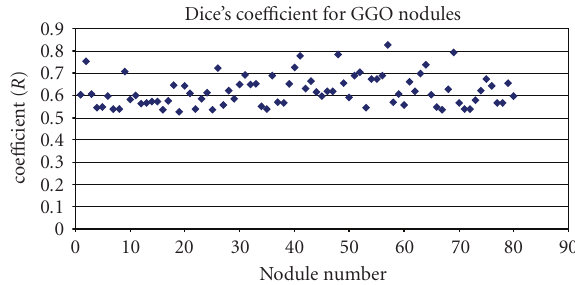
Figure 20: Dice coe ffi cients for GGO nodules based on the proposed method.